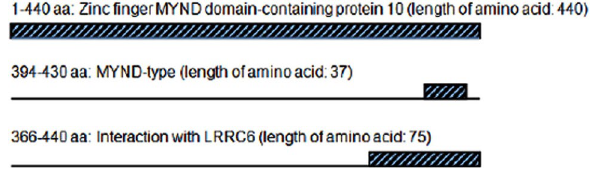
Fig. 1 Scheme of linear structure with motif composition of ZMYND10 protein. A MYND domain with 37 residues capable of binding zinc, conserved among ZMYND family proteins is located at the carboxylterminus, spanning the amino residues 394–430. A 75-residue motif is responsible for interaction with leucine repeat rich component 6 (LRRC6) mutations within which lead to primary cilia dyskinesia. The figure was adapted from [13], reused with permission from Atlas in Genetics and Cytogenetics of Oncology and